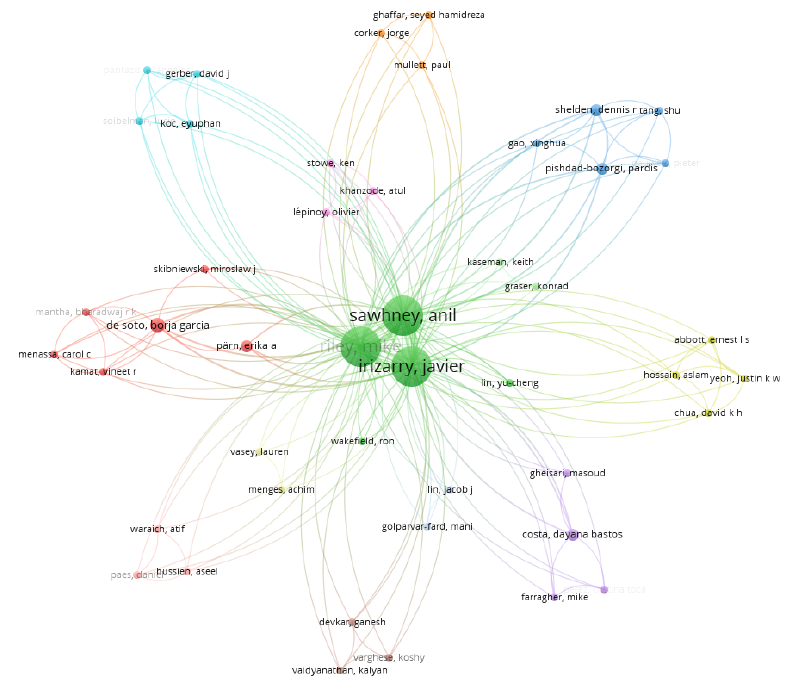
Figure 1. VOSviewer mapping of big data management algorithms, deep learning-based object detection technologies, and geospatial simulation and sensor fusion tools in the Internet of Robotic Things regarding co-authorship.